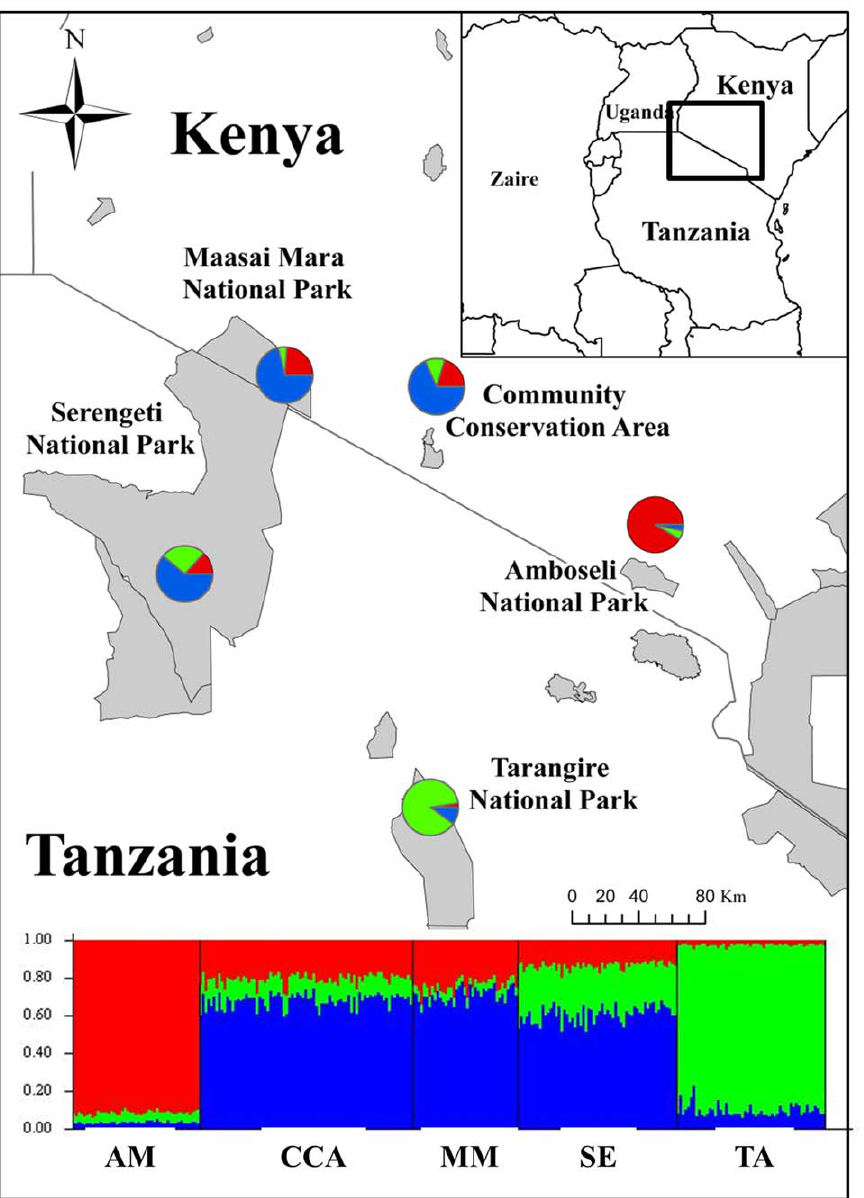
Figure 2. Individual Population Assignment from STRUCTURE. Barplot from STRUCTURE depicting population assignment for individuals mapped and sorted by sampling location: Amboseli (AM), Community Conservation Area (CCA), Maasai Mara (MM), Serengeti (SE) and Tarangire (TA); the Rift Valley splits the study area, Maasai Mara and Serengeti are on the west side of the valley, Amboseli and Tarangire are on the east side of the valley while the CCA is located within the Rift Valley.